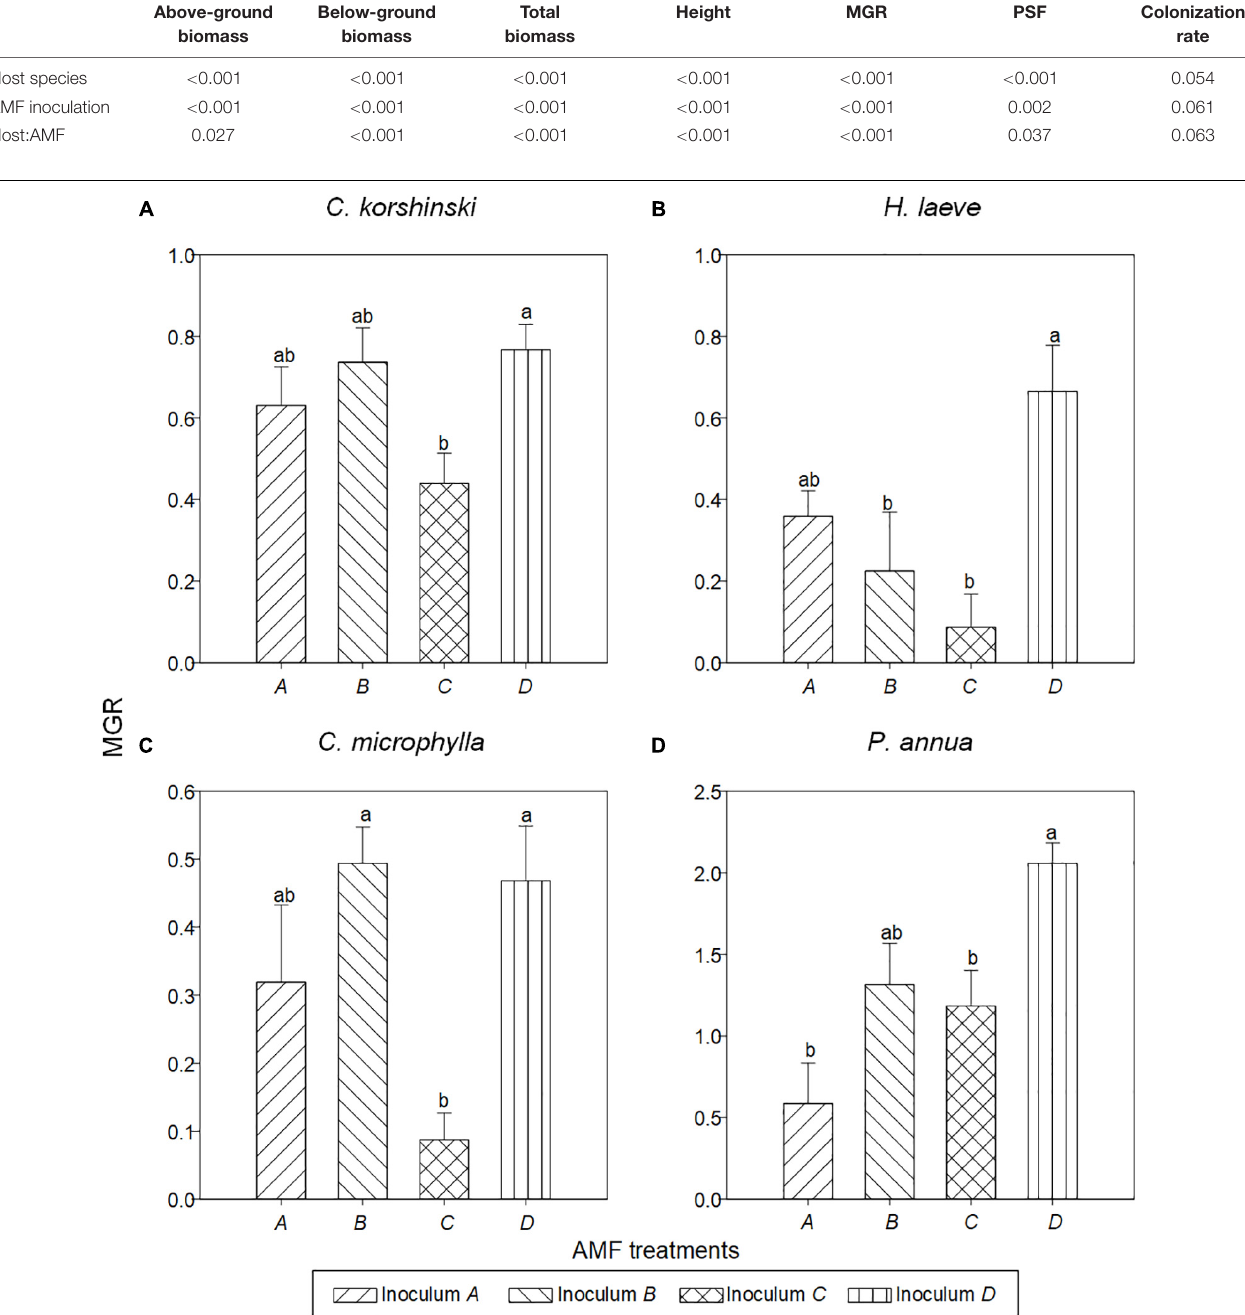
FIGURE 3 | Mycorrhizal growth responses of the AMF inoculation in different plant species: (A) C. korshinski , (B) H. leave , (C) C. microphylla , and (D) P. annua . Different letters above bars indicated significant differences at p < 0.05 level according to Tukey’s